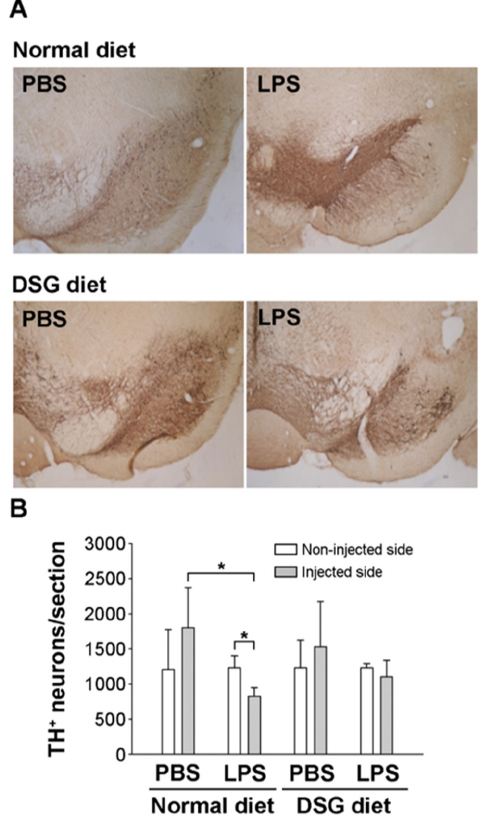
Figure 5. Effects of diosgenin on tyrosine hydroxylase expression in the substantial nigra of a rat model of LPS-induced Parkinson’s disease. Rats with LPS-induced Parkinson’s disease (as shown in Figure 4) were sacrificed after the amphetamine-induced rotation test. SN brain sections were processed for TH immunostaining ( A ). TH-positive neurons in the injected or uninjected SN were calculated using the ImageJ software. ( B ). The results are presented as the means ± SD obtained from 3 different rats in independent experiments. * p < 0.05 compared with uninjected SN or compared with PBS-injected SN.